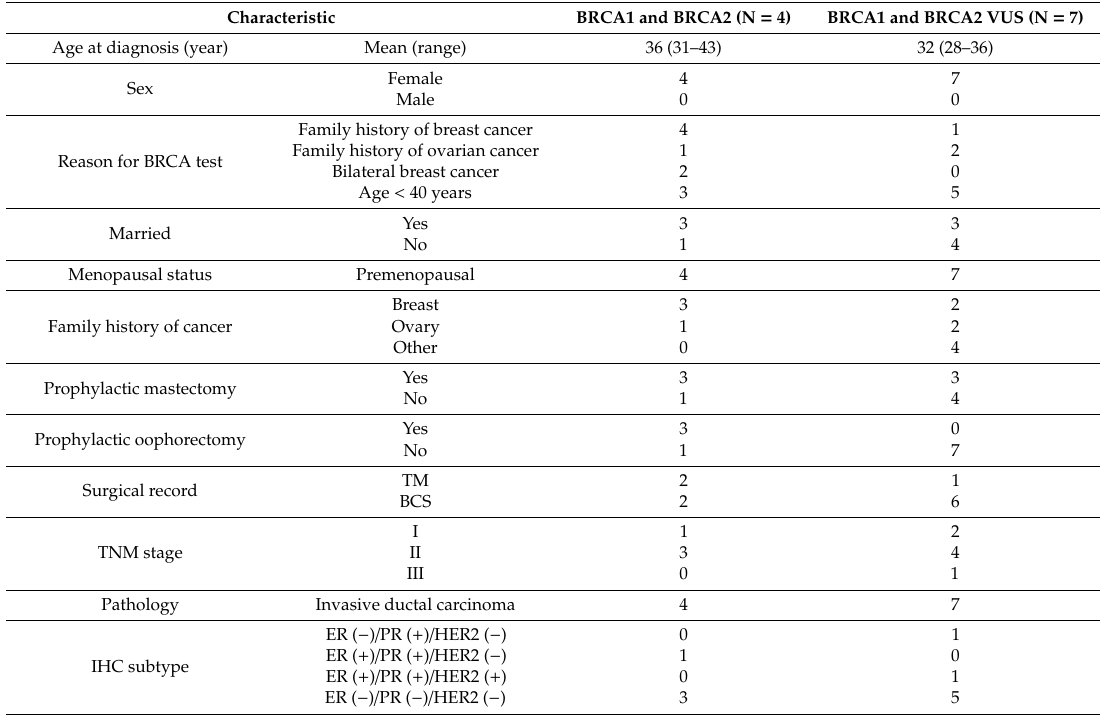
Table 1. Clinical characteristics of patients with mutations in both gBRCA1 and gBRCA2 and patients with gBRCA1 mutation and gBRCA2